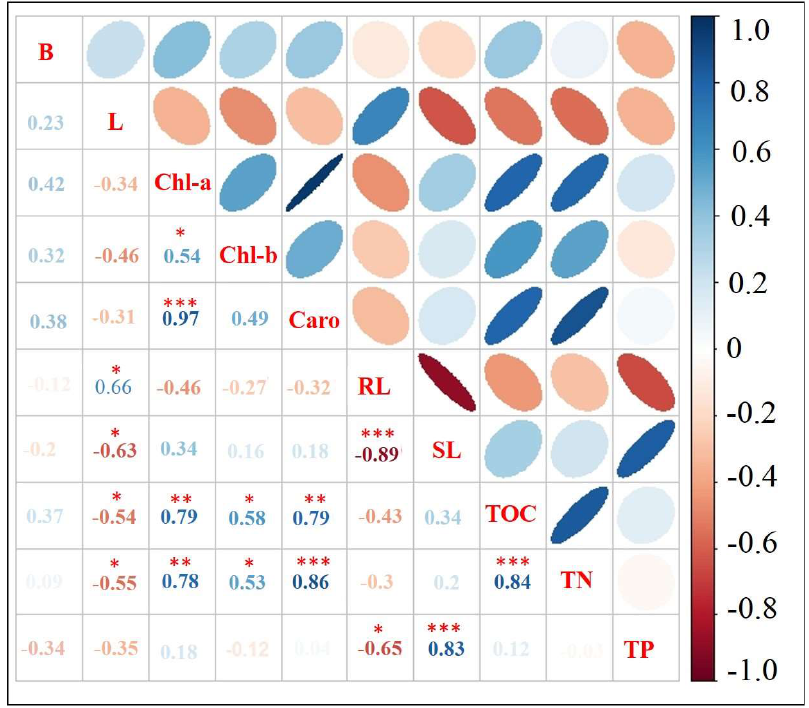
Figure 5. Correlation between microalgal indicators. Biomass (B) represents the final microalgal biomass concentration. Lipid (L) represents the final microalgal lipid contents. Chlorophyll-a (Chl-a) represents chlorophyll-a contents. Chlorophyll-b (Chl-b) represents chlorophyll-b contents. Caotenoid (Caro) represents carotenoid contents. Radius lengths (RL) represents the radius of cells. Spine lengths (SL) represents the microalgal spine lengths. Total organic carbon (TOC) represents the final total organic carbon concentration. Total phosphorus (TP) represents the final total phosphorus concentration. Total nitrogen (TN) represents the final total nitrogen concentration.